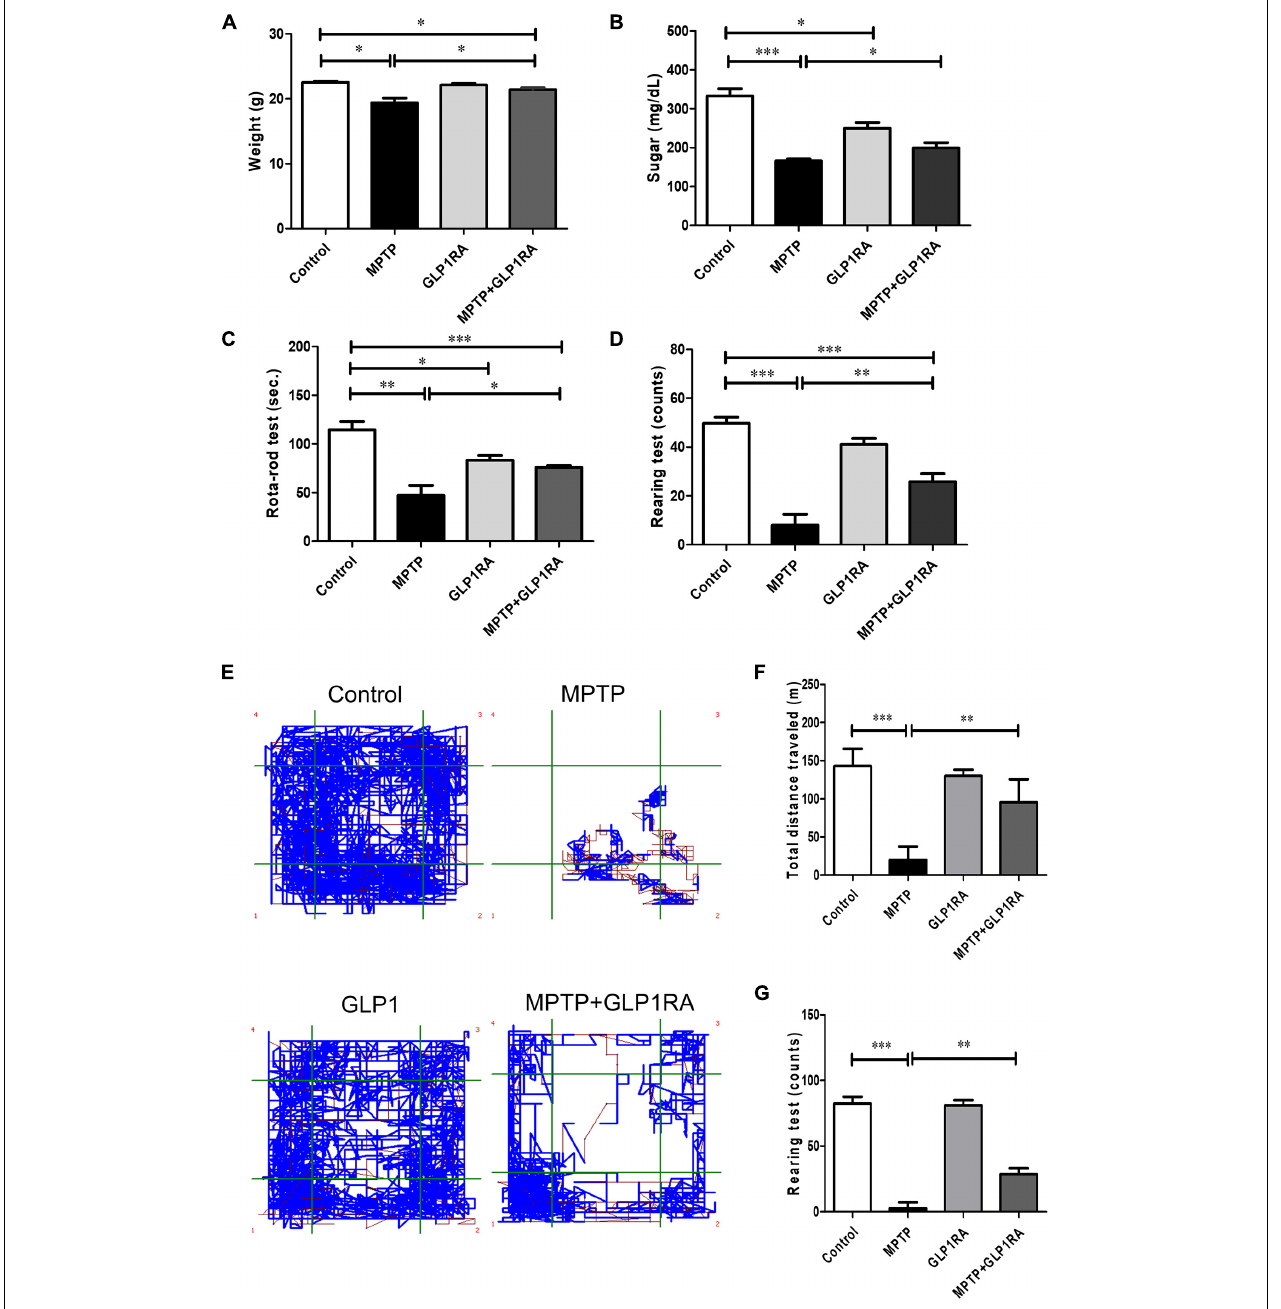
FIGURE 2 | Therapeutic effect of the GLP-1RA (liraglutide) on behavior of MPTP-induced PD mice. Mice were allocated into four groups: control/MPTP/GLP-1RA/MPTP + GLP-1RA. (A) Mice weight: mice weight [gram (g)] was measured on the third day after the last dose of treatment. Control groups: n = 3 per group, treatment groups: n = 7 per group. (B) Blood sugar: mice blood sugar was checked on the third day after the last dose of treatment. Control groups: n = 3 per group, treatment groups: n = 7 per group. (C) The RotaRod test: Mice balance and coordination was measured through the RotaRod test where time to fall from a rotating rod at a speed accelerated from 0 to 40 rpm within 5 min was recorded. An average number of tests over two trials were taken. Control groups: n = 3 per group, treatment groups: n = 7 per group. (D) The rearing test: Spontaneous motor initiation and coordination alteration were observed via the rearing test. Mice were placed in an 8 cm (diameter) × 12 cm (height) cylinder and the number of rears were counted over 5 min. An average number of tests over two trials were taken. n = 3 per group for control groups and n = 7 per group for treatment groups. (E–G) The open field test: The explorative locomotion in mice was examined via the open field test. Mice were placed in a 30 cm * 30 cm acrylic cage and the total distance traveled [meters (m)] and number of rearing events over 15 min were measured to evaluate explorative locomotion. Control groups: n = 3 per group, treatment groups: n = 7 per group. The values represent mean ± SD (one-way ANOVA * P < 0.05, ** p < 0.01, *** P < 0.001). GLP-1RA, glucagon-like peptide-1 receptor